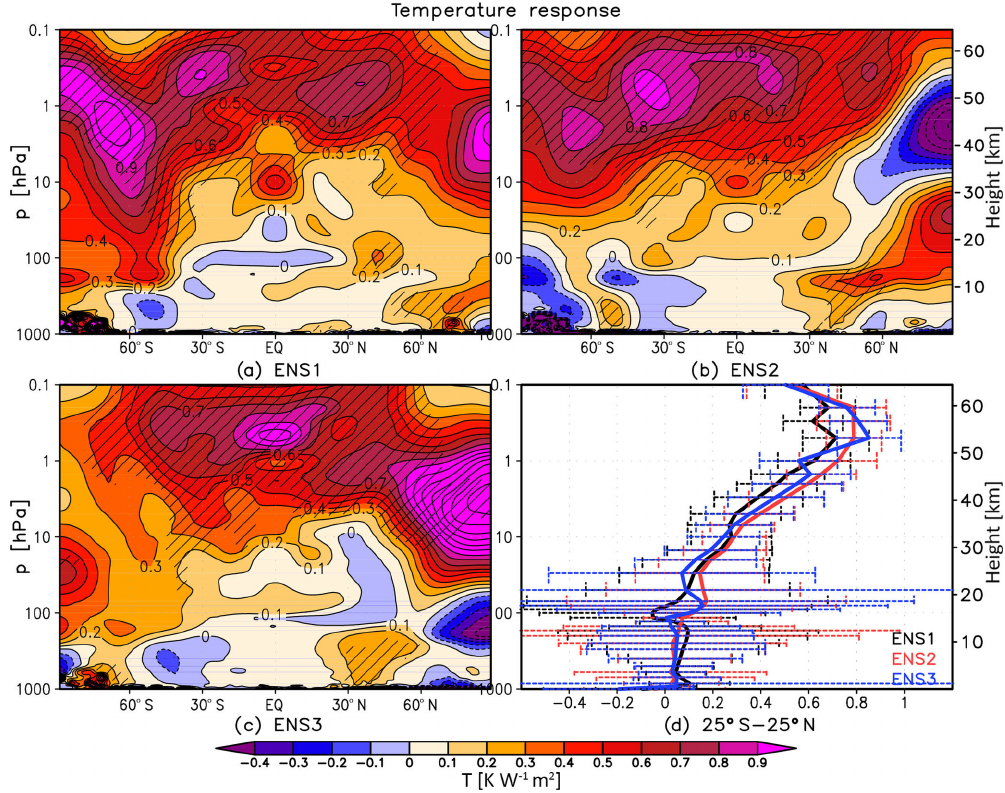
Figure 10. (a–c) Yearly mean zonal mean temperature response (KW − 1 m 2 ) in UM-UKCA derived using MLR for the individual ensem- ble members (ENS1-3). Hatching indicates statistical significance on the 95% level ( t test). Contour spacing is 0.1KW − 1 m 2 . (d) The corresponding yearly mean temperature responses in the tropics together with the associated confidence intervals ( ± 2 standard